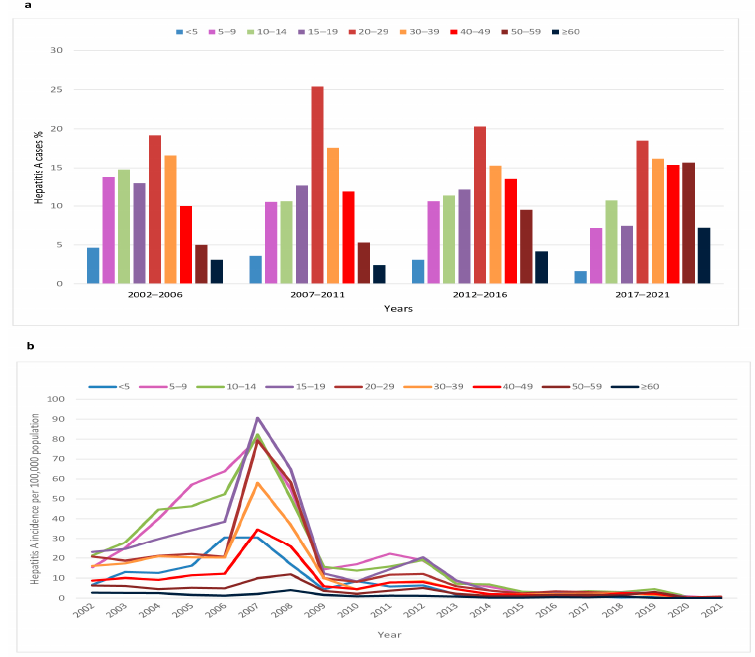
Figure 2. Age-specific hepatitis A ( a ) cases and ( b ) incidence per 100,000 population in Serbia, 2002 – 2021.